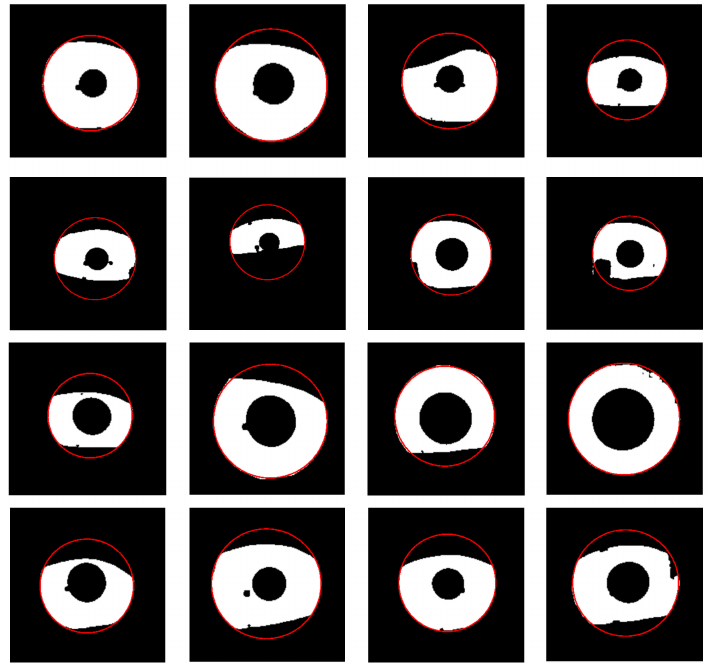
Figure 18. Visualization of predicted results on different iris